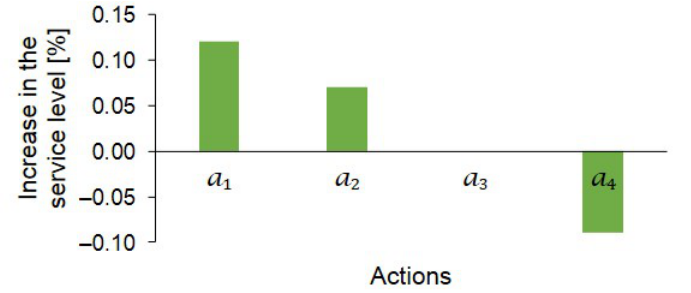
Figure 6. Impact of actions on the service